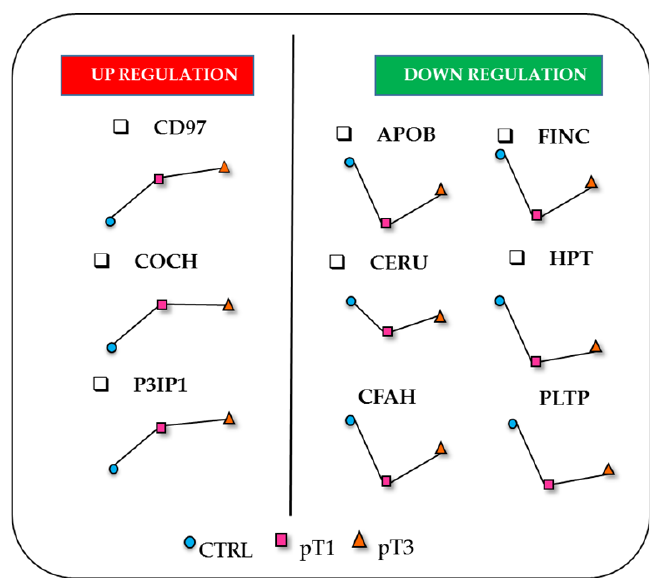
Figure 4. Panel of urinary N -glycosylated proteins with the relative abundance trend of each one in the three different sub-cohorts (CTRL, pT1, pT3).